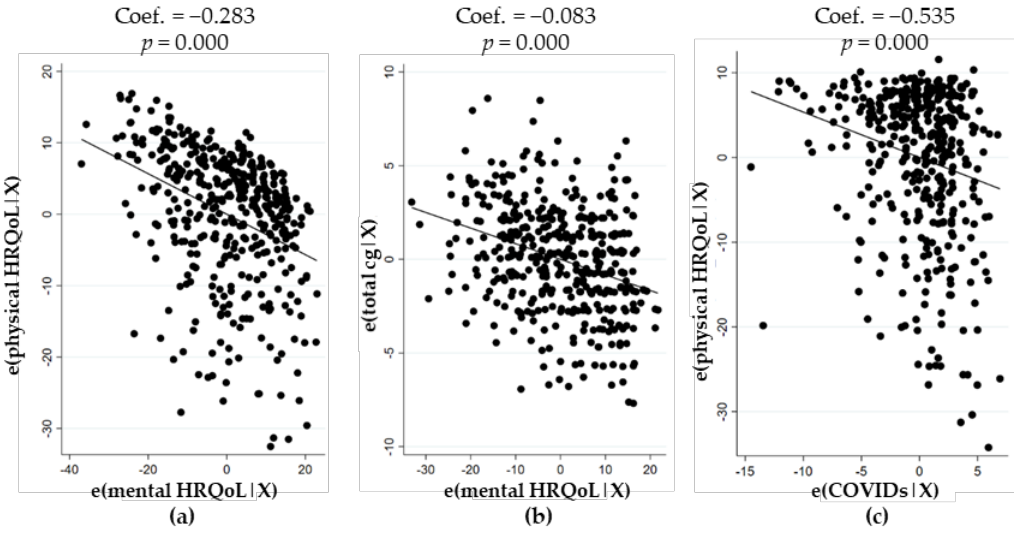
Figure 2. Association of mental HRQoL scores with physical HRQoL scores of participants ( a ); with the cumulative number of changes experienced (total cg) by the participants ( b ); and of the physical HRQoL score with the risk perception of COVID-19 score (COVIDs) ( c ).